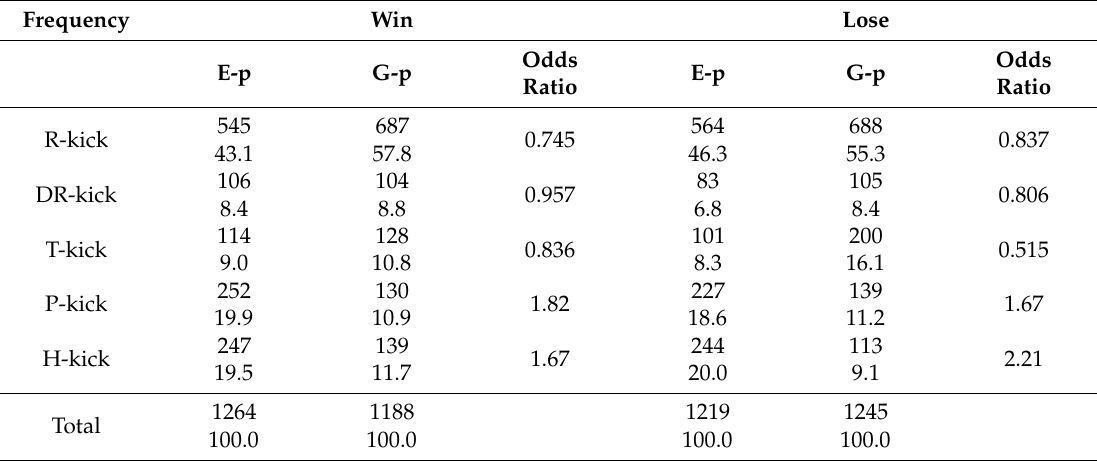
Table 7. Observed frequencies (proportions) and odd ratios for skill by protector by win / lose contingency